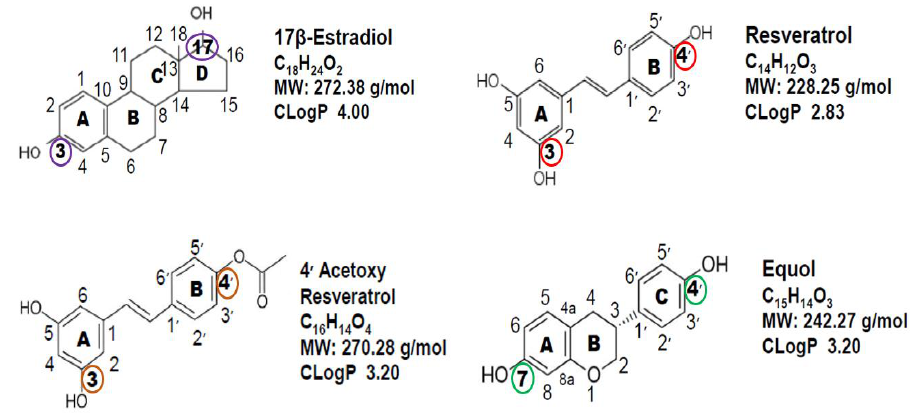
Figure 1. Comparison of the chemical structures, molecular formulas, molecular weights and CLogP values among 17β-estradiol, resveratrol, 4′ acetoxy resveratrol and equol. CLogP = the logP value of a compound representing its partition coefficient and lipophilicity. The purple circles at carbon 3 and 17 for 17β-estradiol represent the functional positions; the red and brown circles at carbon 3 and 4′ represent the functional positions for resveratrol and 4′ acetoxy resveratrol, respectively, and the green circles at carbon 7 and 4′ represent the functional positions for equol.